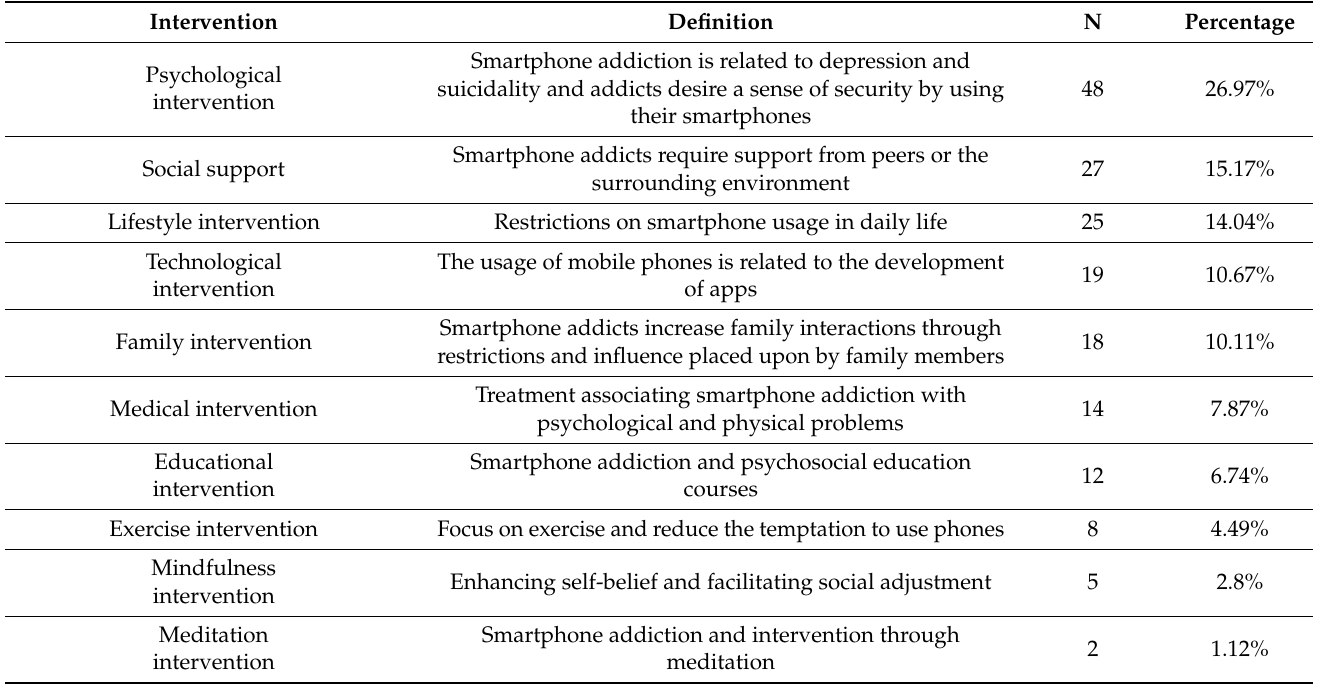
Table 4. Intervention programs, definitions, frequencies, and percentages.